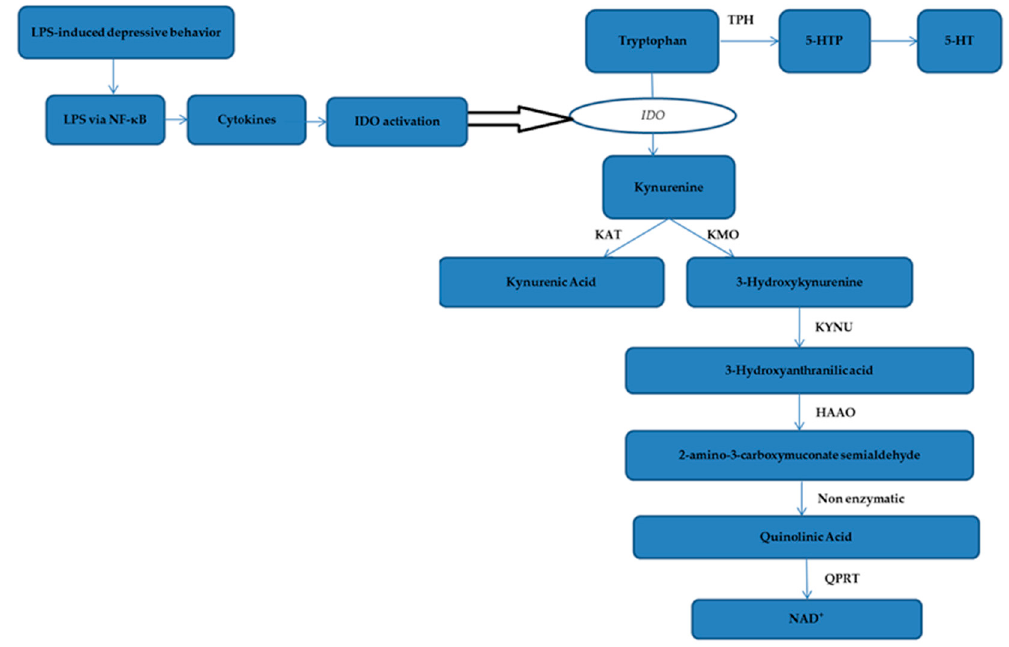
Figure 7. IDO pathway and tryptophan metabolism pathway. Notes: Tryptophan catabolism through the kynurenine pathway involves IDO as an intracellular rate–limiting enzyme. Pro-inflammatory cytokine is upregulated by LPS regulated by NF- κ B. Activation of NF- κ B results in the release of pro-inflammatory cytokines, which in turn, activates IDO activity. Tryptophan may be metabolized to serotonin or alternatively, is metabolized via the kynurenine pathway. Tryptophan is metabolized to kynurenine by indoleamine 2,3-dioxygenase. Kynurenine is then converted via kynurenine aminotransferases (KAT) to kynurenic acid, a neuroprotective molecule as it antagonizes glutamate receptor-induced neurotoxicity. In addition, kynurenine can also be converted to 3-hydroxykynurenine by kynurenine-3-monooxygenase (KMO), for which evidence is accumulating of its neurotoxic capability. Sequential conversion to 2-amino-3-carboxymuconate-semialdehyde is the penultimate step leading to enzymatic production of (neuroprotective) picolinic acid, and the (non-enzymatic) production of the well-known neurotoxic compound quinolinic acid. Further conversion of QUIN to the essential cofactor NAD + is catalysed by quinolinate phosphoribosyltransferase (QPRT).